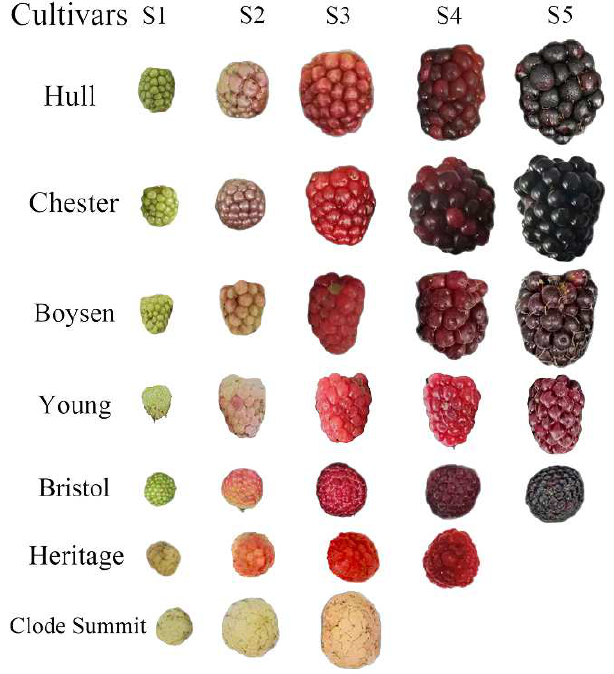
Figure 1. Appearance of different cultivars of Rubus in different fruit developmental stages.